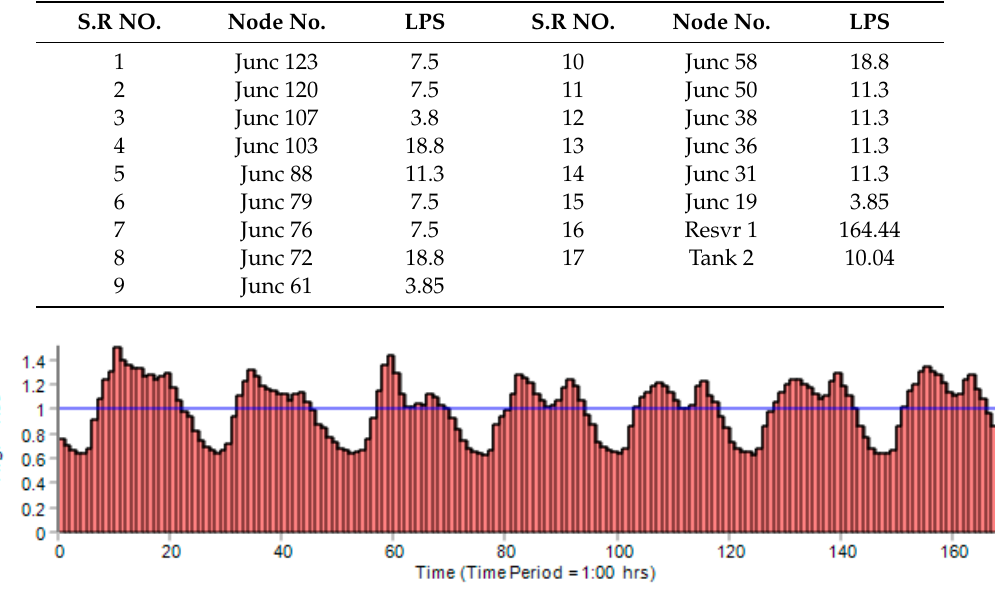
Figure 3. Demand pattern variation of the water distribution system (WDS) with respect to time [23].